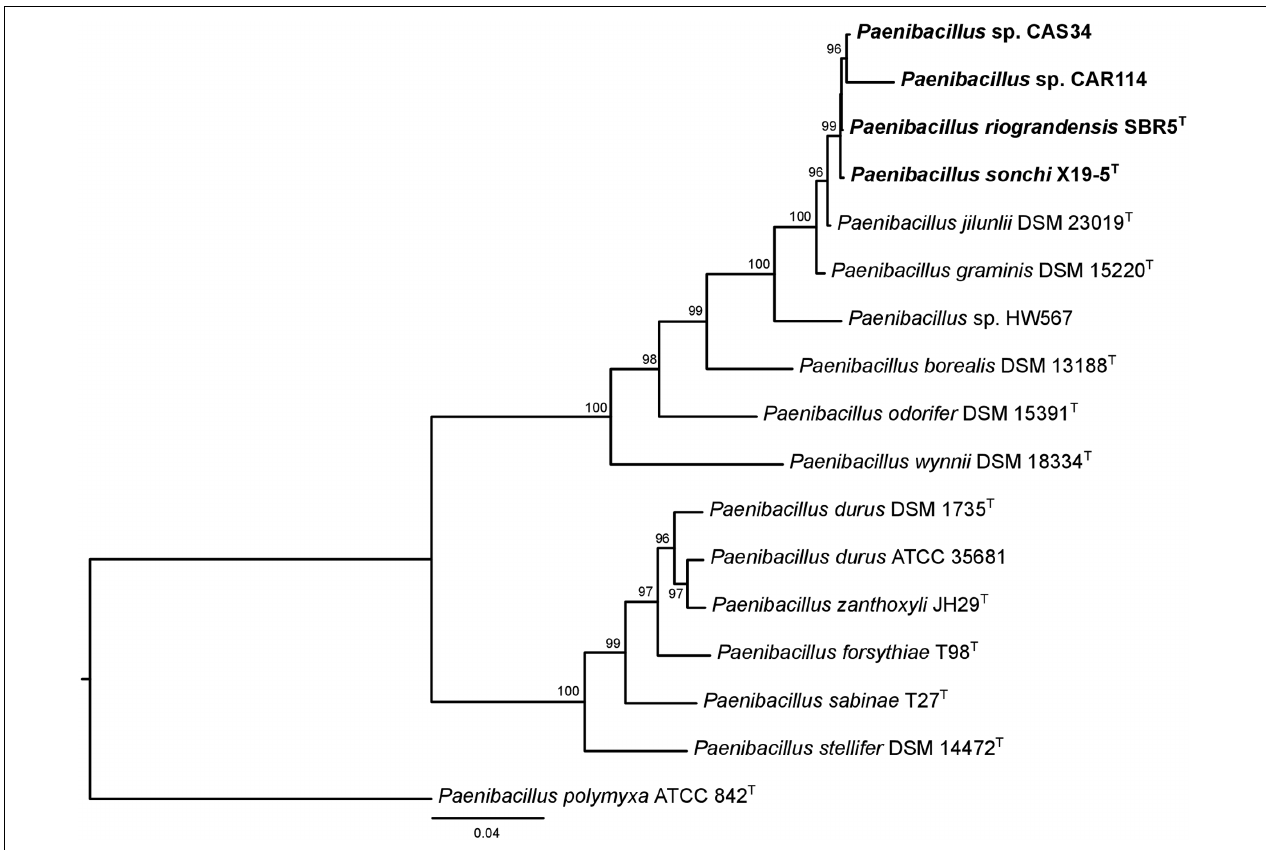
FIGURE 6 | AMPHORA multiprotein phylogeny of Paenibacillus species. The multiprotein rooted tree was constructed using the maximum-likelihood method. Details are as shown in Figure 1 , unless specified